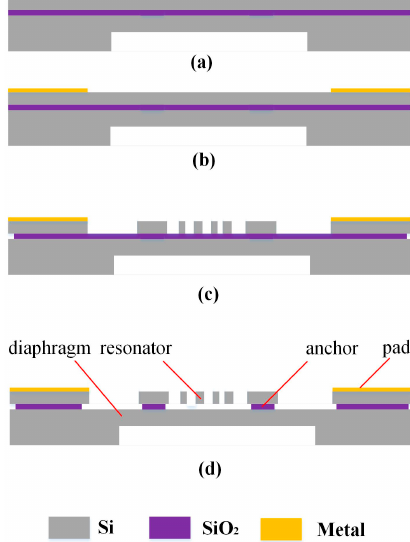
Figure 6. The fabricating process of the sensor. ( a ) The handle layer of a SOI wafer is etched by DRIE; ( b ) The metal Au is deposited selectively in the surface of device layer to form pads; ( c ) The device layer is etched to the buried oxide layer by DRIE to form the resonator structure; ( d ) The exposed buried oxide layer is etched by hydrogen